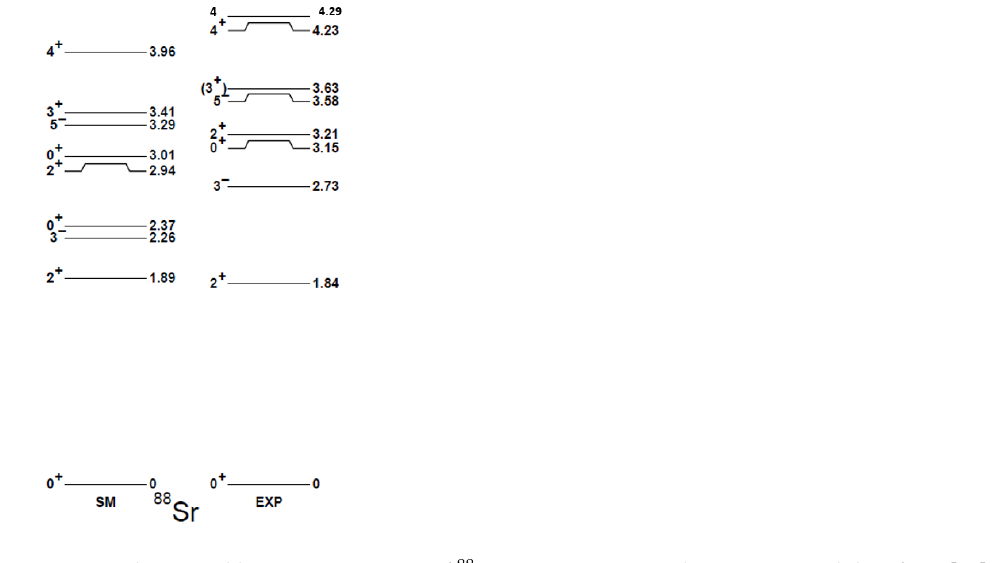
Figure 5. Theoretical low-energy spectra of 88 Sr in comparison to the experimental data from [29].